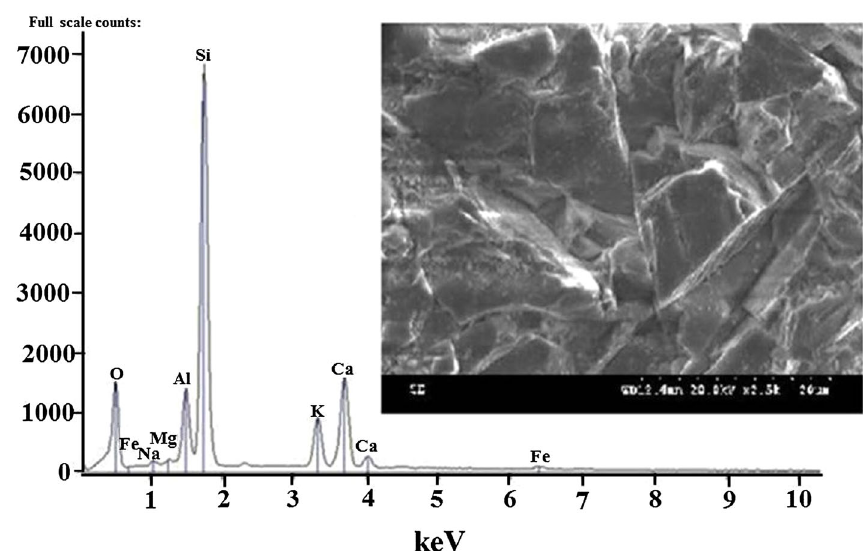
Fig. 7 SEM analysis for